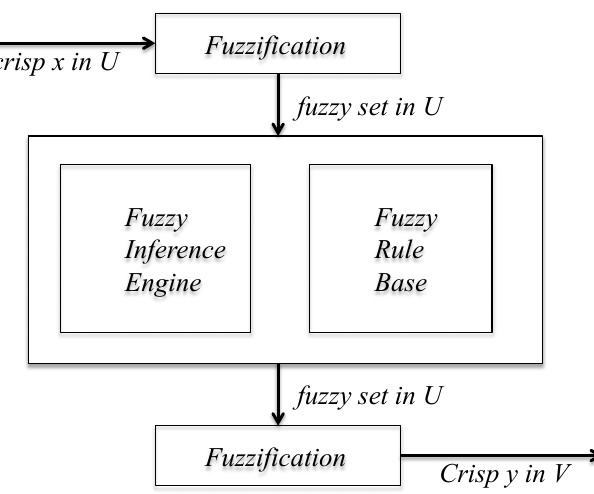
Figure 1. A fuzzy logic controller according to Lee